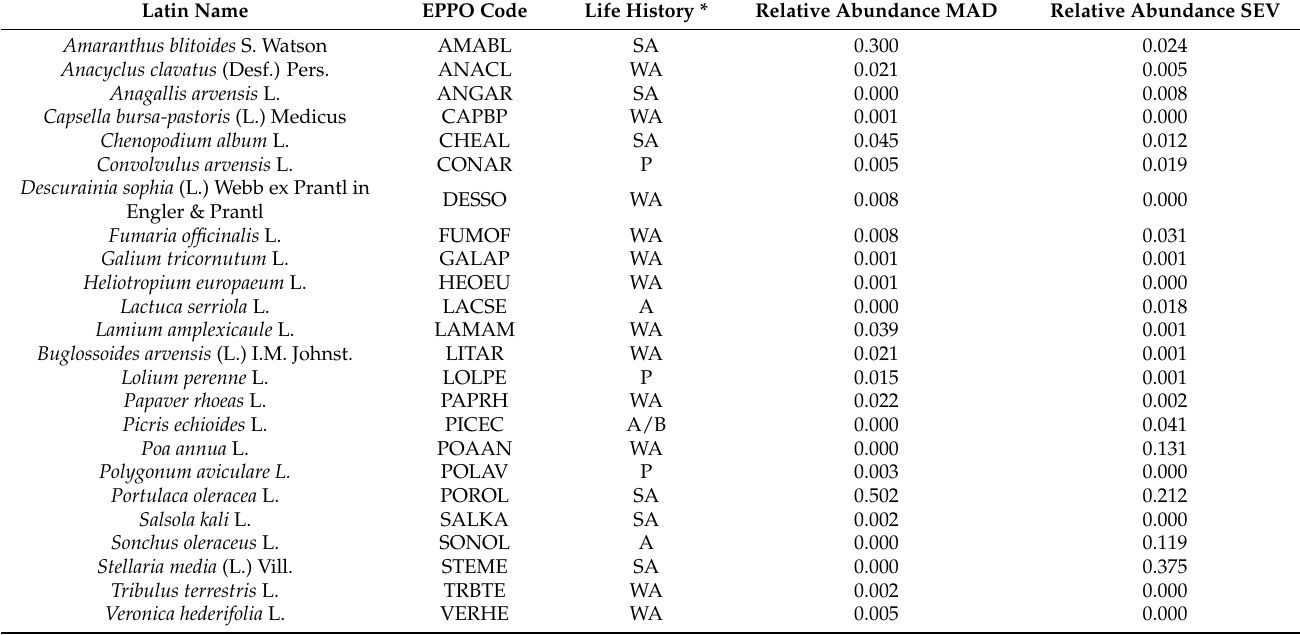
Table 1. Weed seed bank composition in each location object of study (Madrid and Seville). * A, annual; WA, winter annual; SA, summer annual; P, perennial; A/B, annual or biennial. Flora Ib é rica determined life histories of